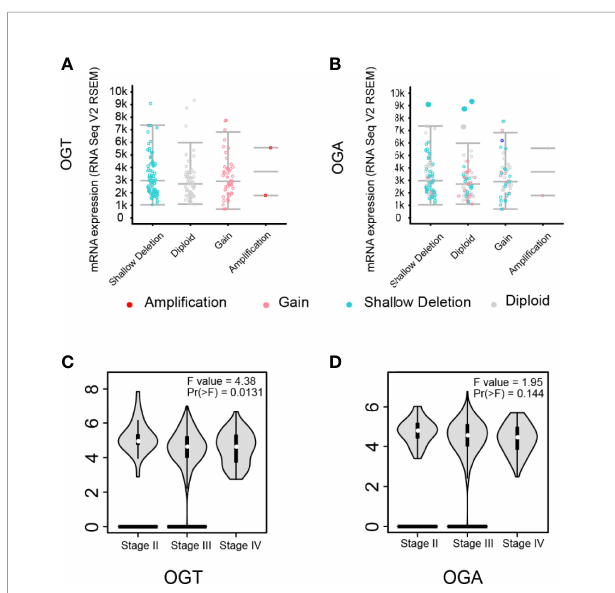
FIGURE 5 | Aberrant expression of OGT was correlated with pathological stage in ovarian cancer. (A-B) Putative copy-number alterations of OGT/ OGA. (C-D) The distribution of OGT mRNA expression correlated with tumor stage in ovarian cancer patients (p <